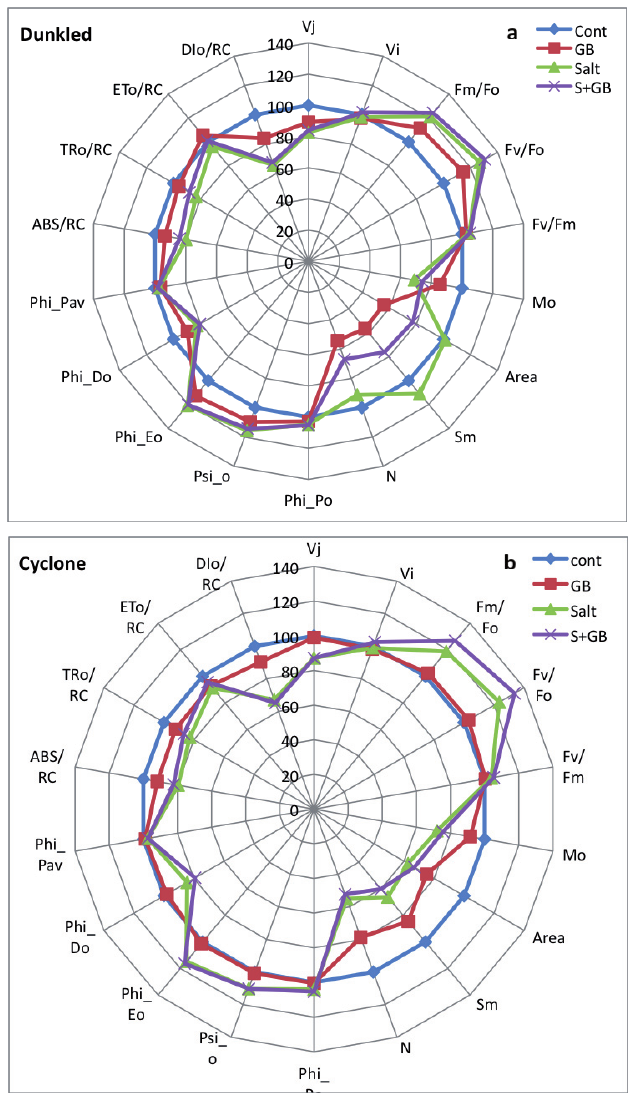
Fig. 6: Radar plot of JIP test parameters of two cultivars of canola ( Brassica napus L.) when three week old plants were subjected to foliar application of glycinebetaine and salt stress for further two Tab. 1: Mean squares from analysis of variance of data for V J , V I , Fv/Fo, Fv/Fm and Fm/Fo in leaves of two cultivars of canola ( Brassica napus L.) treated with or without foliar spray of GB to salt stressed and non stressed condition. Source of variance